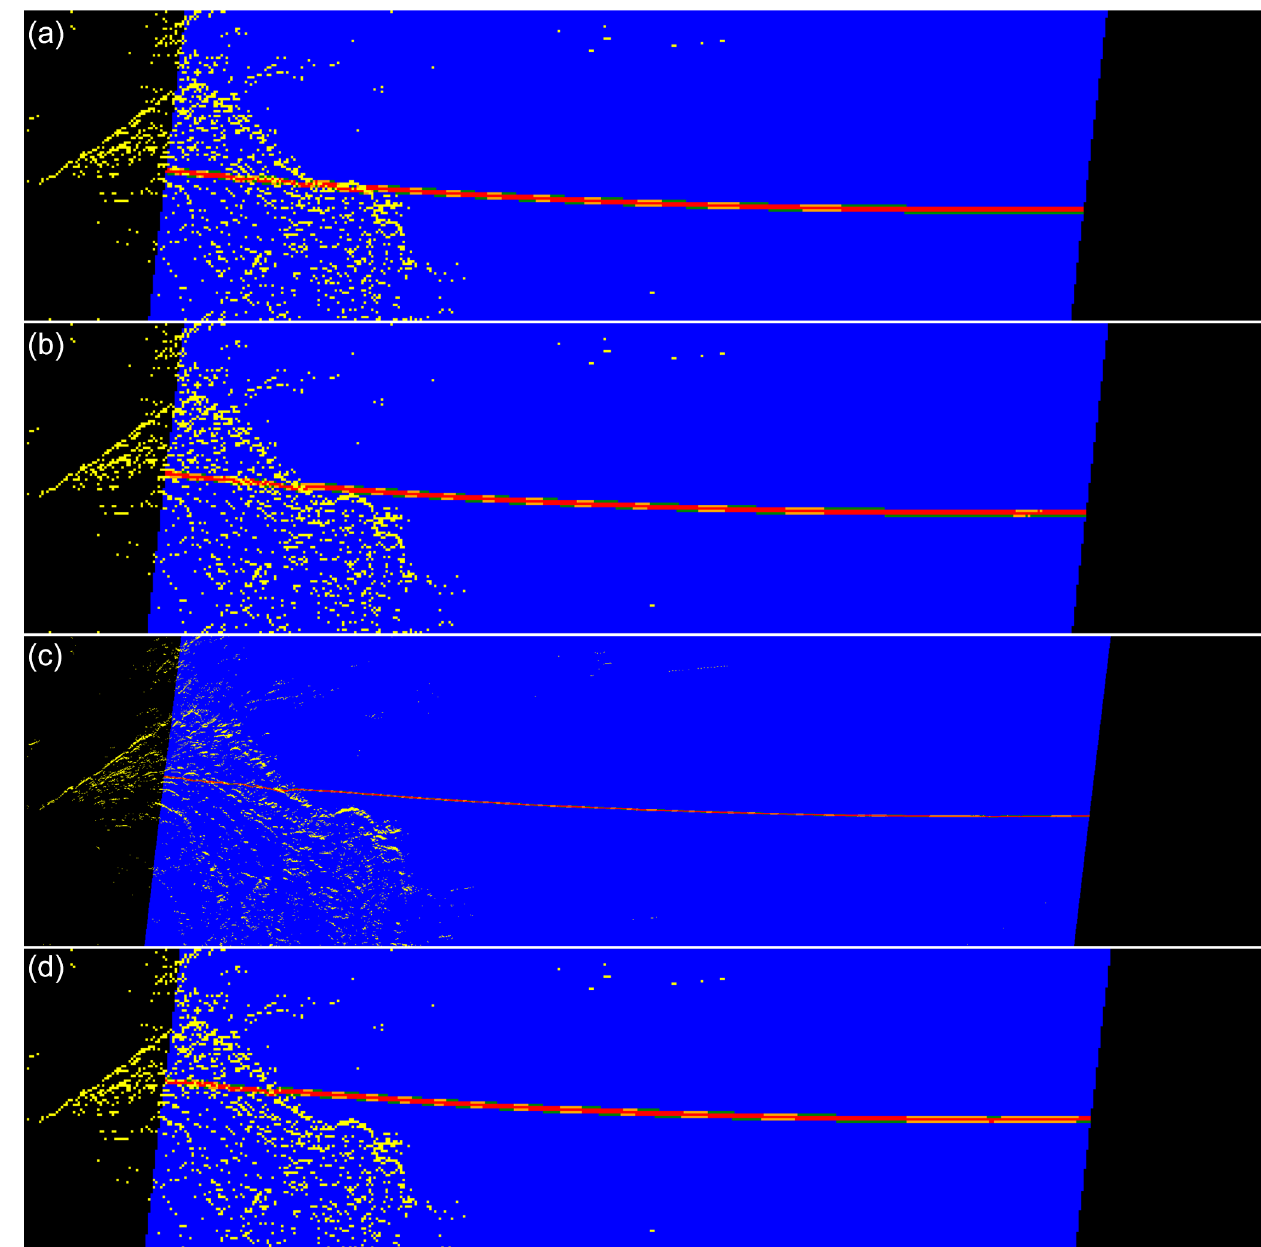
Figure 10. Spatial distribution of RDQI values for G LOBAL M ODE , P ATH 168, O RBIT 65487, B LOCK 110 and camera CA in the four spectral bands (from top to bottom: blue, green, red and NIR). Black: edge pixels; yellow: pixels obscured by the local topography; blue: RDQI = 0; green: RDQI = 1; orange: RDQI = 2; red: RDQI = 3.